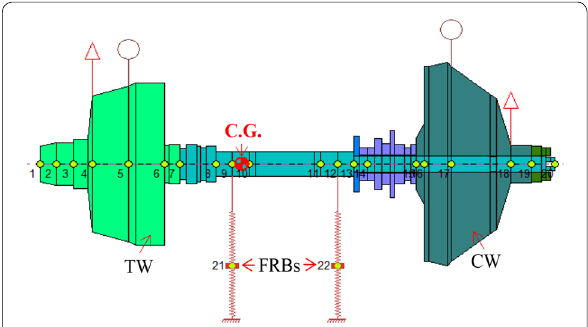
Figure 3 FEM of high‑speed TC rotor with